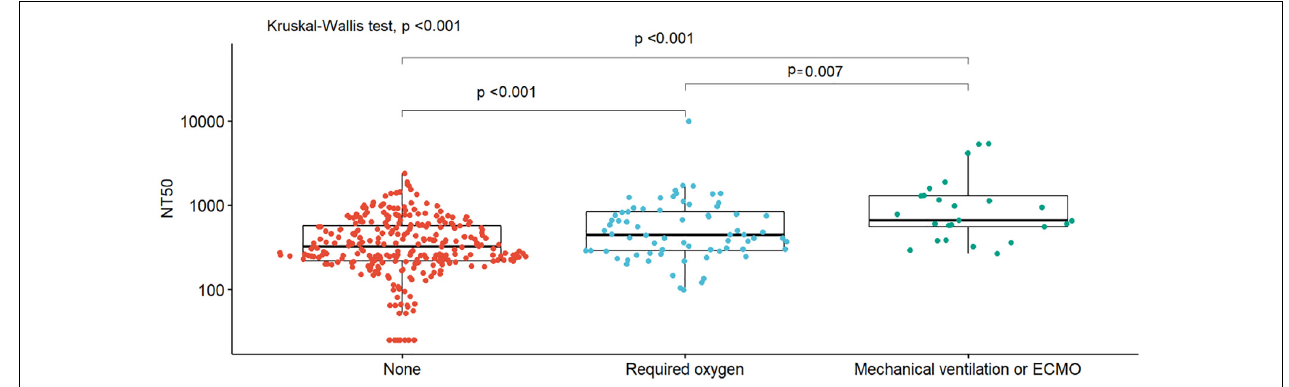
FIGURE 1 | Box plots of NT 50 titers by oxygen support. Box plots of neutralizing titers (NT 50 ) by oxygen support requirements (none, required oxygen, invasive mechanical ventilation, or extracorporeal membrane oxygenation [ECMO]), with the density distribution of the data within each group, are shown. Differences in distributions between groups were assessed using nonparametric methods (Wilcoxon signed rank sum or Kruskal–Wallis).